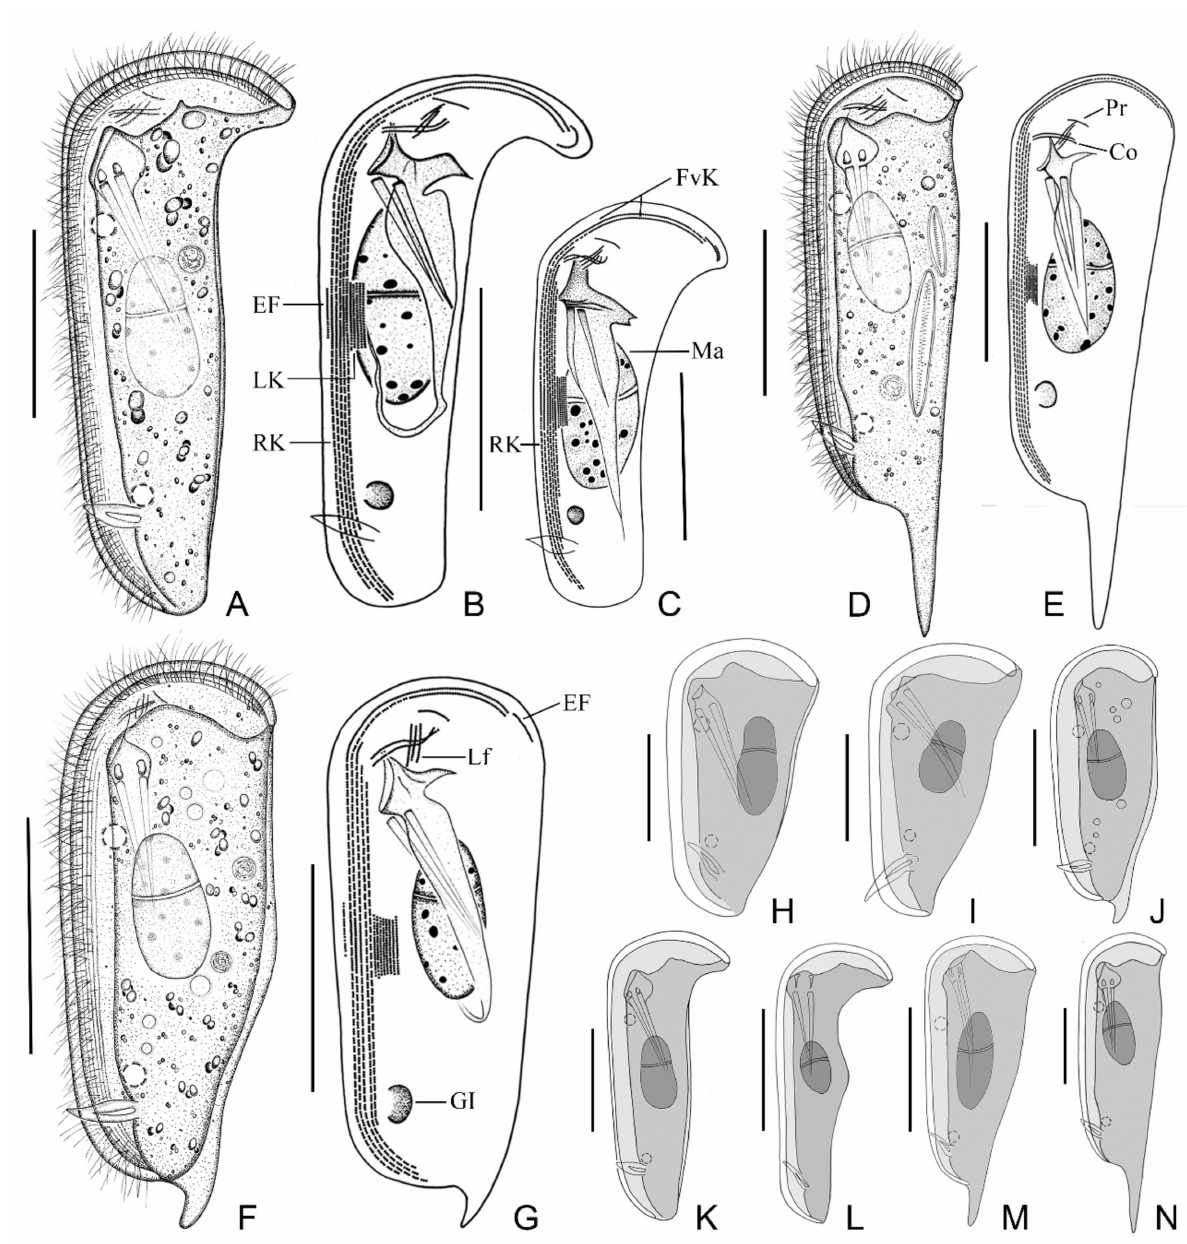
Figure 3. Dysteria brasiliensis from life ( A , D , F , H – N ) and after protargol staining ( B , C , E , F ). ( A ) Left lateral view; note that anterior portion is distinctly wider than other parts of cell. ( B , C ) Left view showing infraciliature; note that one cell has five right kineties ( B ) and the other has six right kineties ( C ). ( D ) Left lateral view of an individual with a long dorsal spine. ( E ) Left view showing infraciliature of an individual with a long dorsal spine. ( F ) Left lateral view of a representative individual. ( G ) Left view showing infraciliature. ( H – N ) Left lateral views of differently shaped individuals ( H , I , L , M ) from Gong et al. [9]. Co, circumoral kineties; EF, equatorial fragment; FvK, frontoventral kineties; GI, glandule; Lf, left front kineties; LK, left kineties; Ma, macronucleus; P, podite; Pr, preoral kinety; RK, right kineties; TF, terminal fragment. Scale bars = 80 µ m ( A – G ); 30 µ m ( H , I ); 60 µ m ( J – N